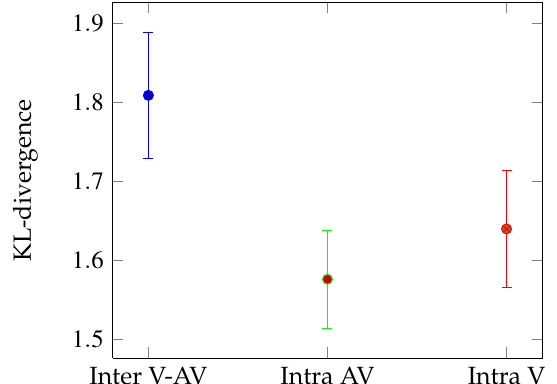
Figure 3 . Mean Kullback-Leibler divergence between the eye position distributions in the V and AV conditions (blue), be- tween two sets of eye positions extracted from the AV (green) and the V (red) conditions. Error bars correspond to standard